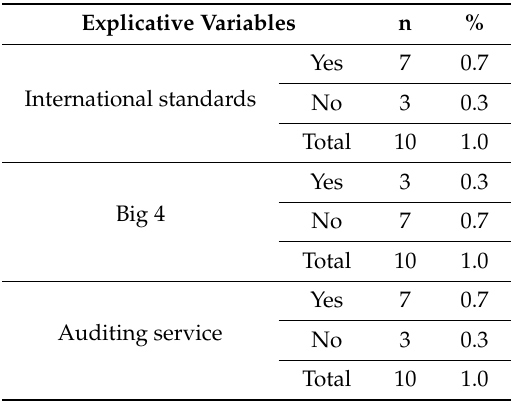
Table 4. Sample composition: explicative variables.